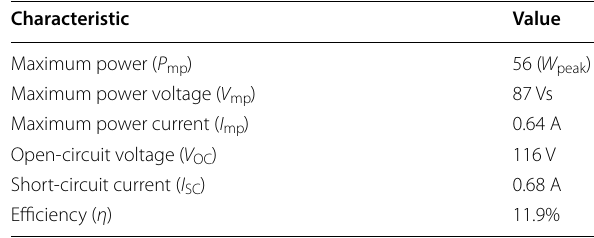
Table 24 Electrical characteristics of PS-CT-56 (CdTe) panel with 30% of transparency. Sourced from